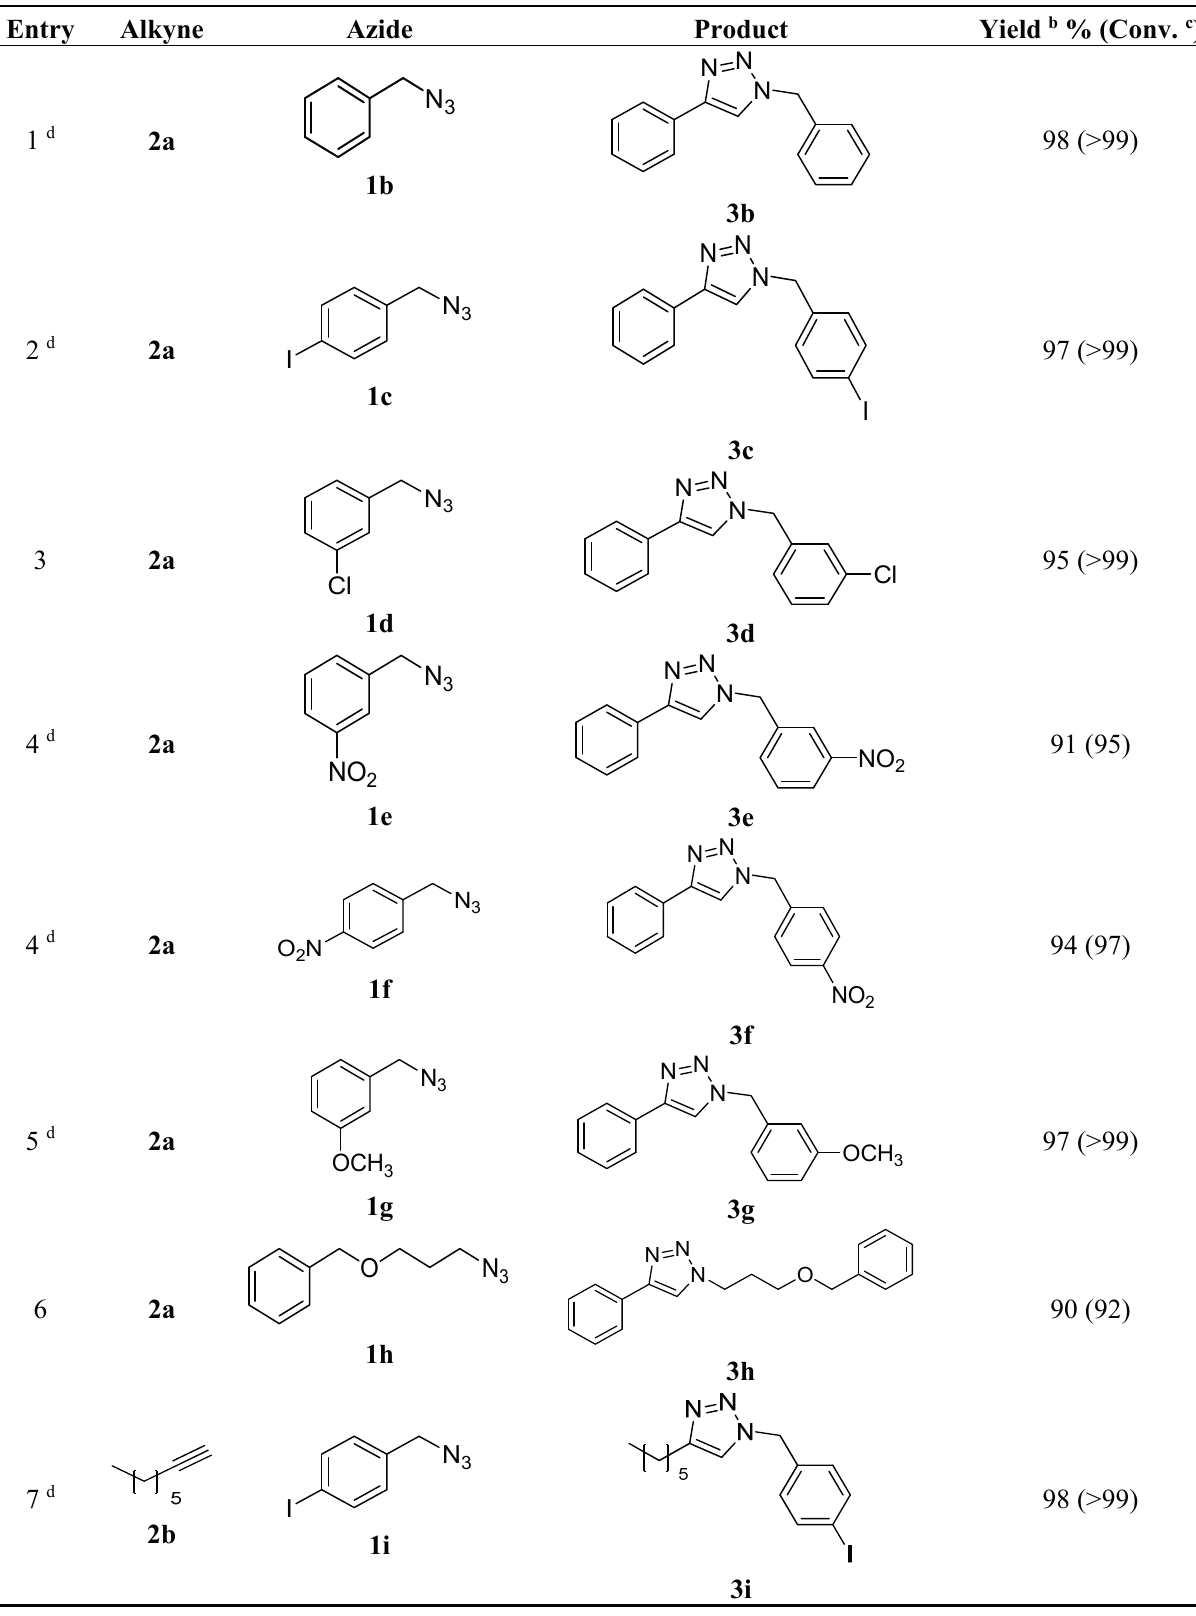
Table 3. Synthetic results of mechanochemical CuAAC a